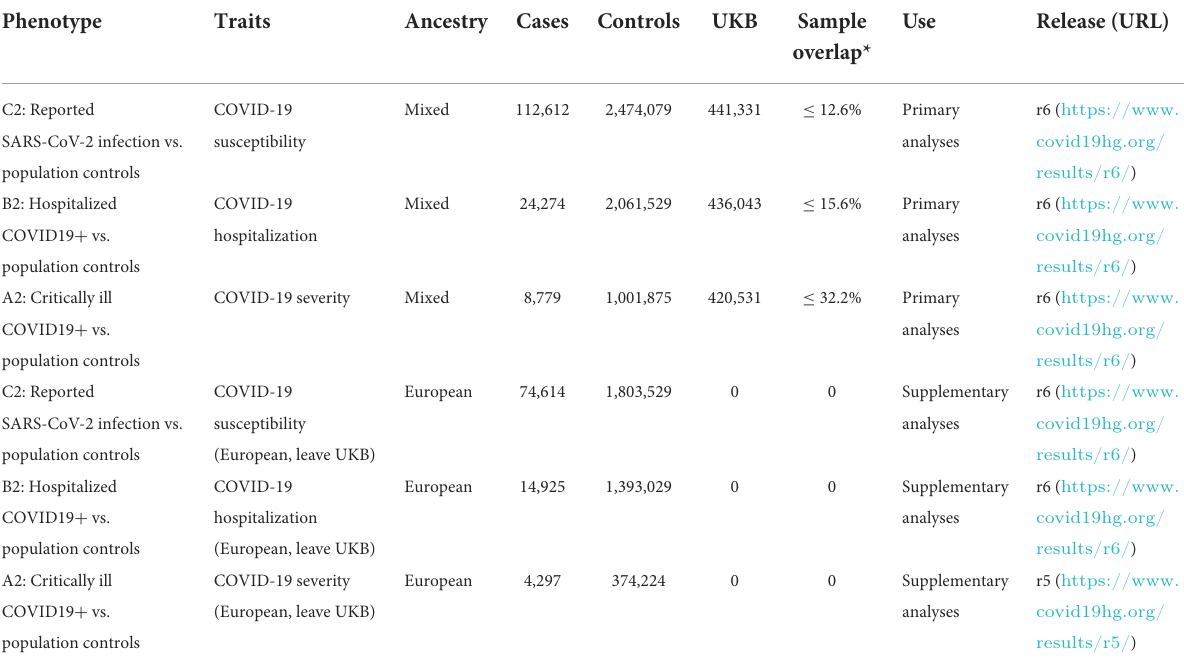
TABLE 1 Characteristics of the data sources for COVID-19